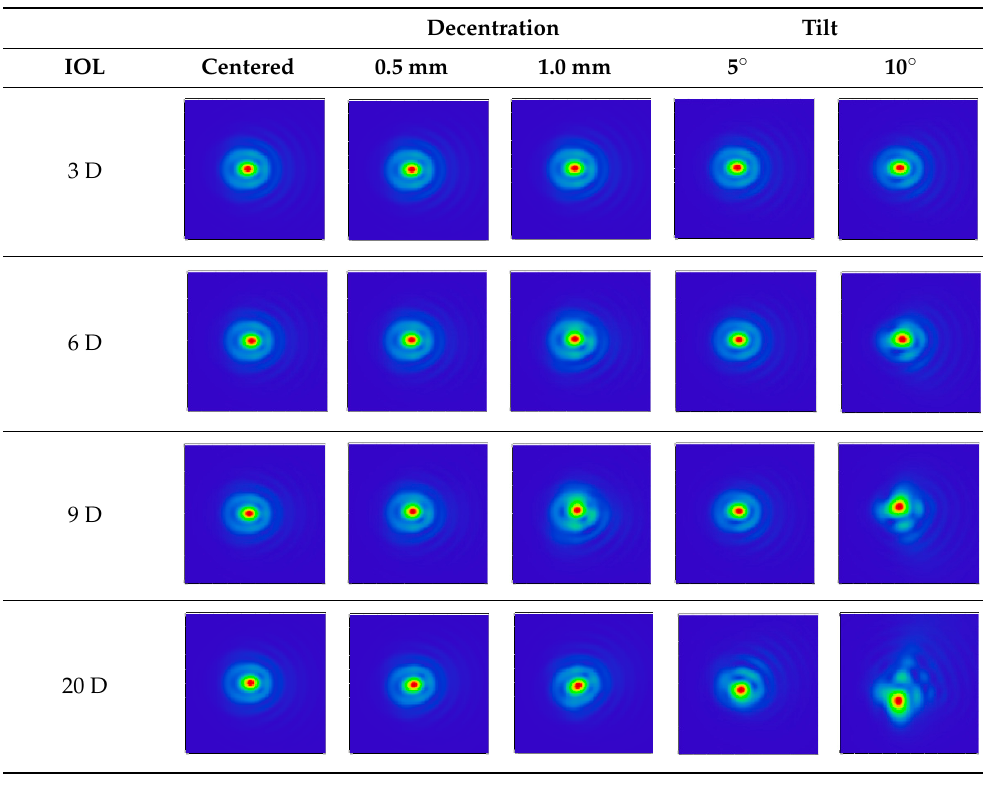
Table 1. The point-spread function of the IOLs assessed at the on-axis position, with decentration and tilt.